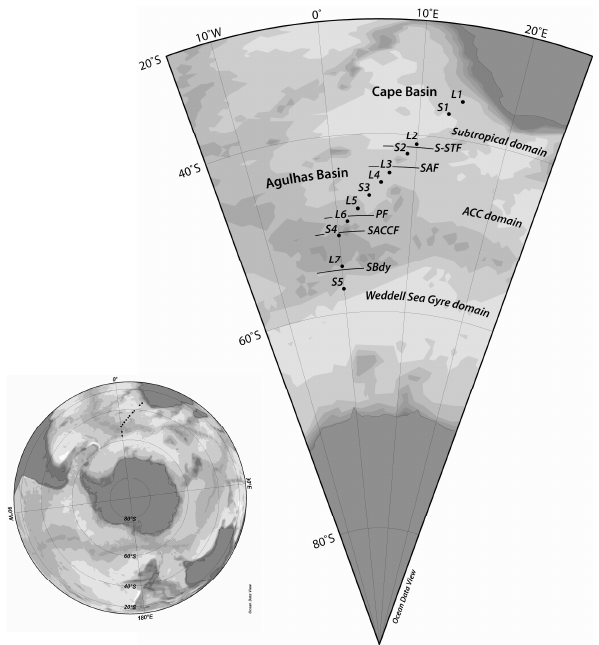
Fig. 1. Location of the stations sampled during the BONUS- GoodHope cruise along with the three main oceanographic provinces encountered (a larger scale of the studied area is given in the inset map). The three domains crossed were the subtropi- cal domain (stations L1, S1 and L2), the ACC domain (stations S2, L3, L4, S3, L5, L6, S4 and L7) and the eastern part of the Wed- dell Sea Gyre (station S5). Five fronts were crossed: the southern- subtropical front (S-STF), the sub Antarctic front (SAF), the po- lar front (PF), the southern ACC front (SACCF) and the southern boundary